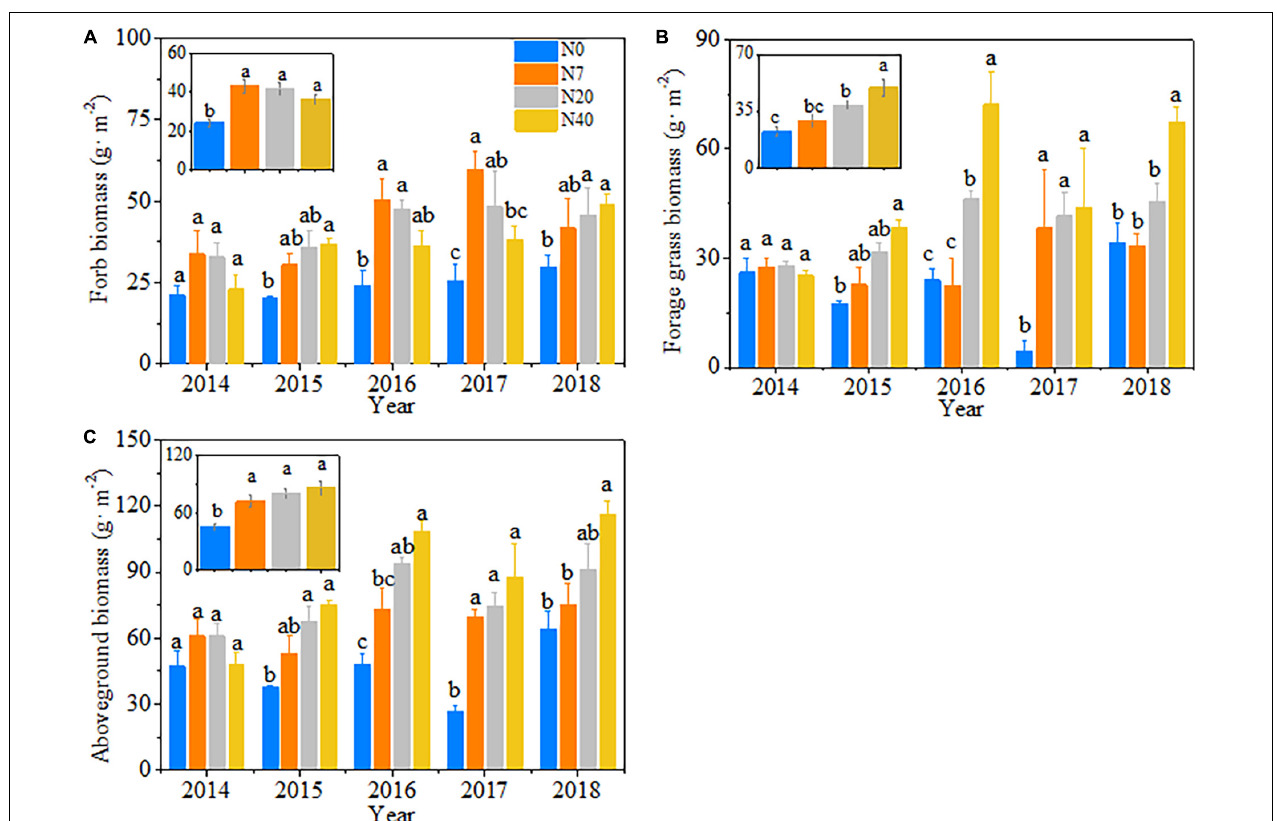
FIGURE 2 | Patterns in (A) forb biomass, (B) forage grass biomass, and (C) aboveground biomass with increasing N addition from 2014 to 2018. The error bars represent the standard error (SE). N0–N40: expressed as control, 0, 7, 20, and 40 kg N ha − 1 year − 1 . Different lowercase letters indicate the significant differences ( p < 0.05) among different N-addition